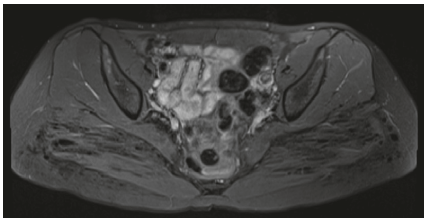
Figure 2: MRI of pelvis showing innumerable small low signal foci throughout the gluteus maximus and overlying subcutaneous fat